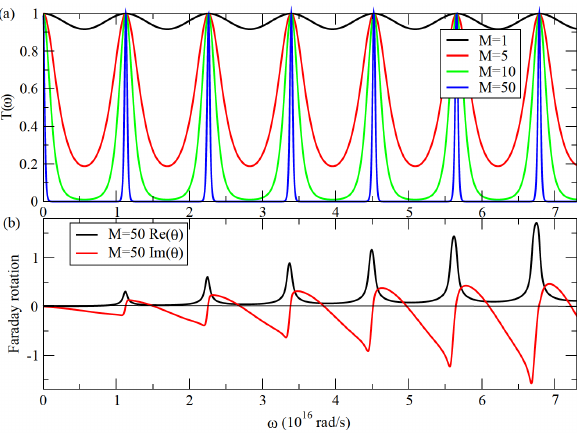
Figure 4: (a)The transmission coeflcient and (b) real and imaginary parts of the Faraday Rotation angle θ as a function of ω for an alter- nating structure described in the text. The parameters are: number of primitive cells M = 50 , n 1 = 1.58 , n 2 = −2.12 , L 1 = 52.92 nm, L 2 = 39.38 nm and n 1 L 1 = | n 2 | L 2 (colour